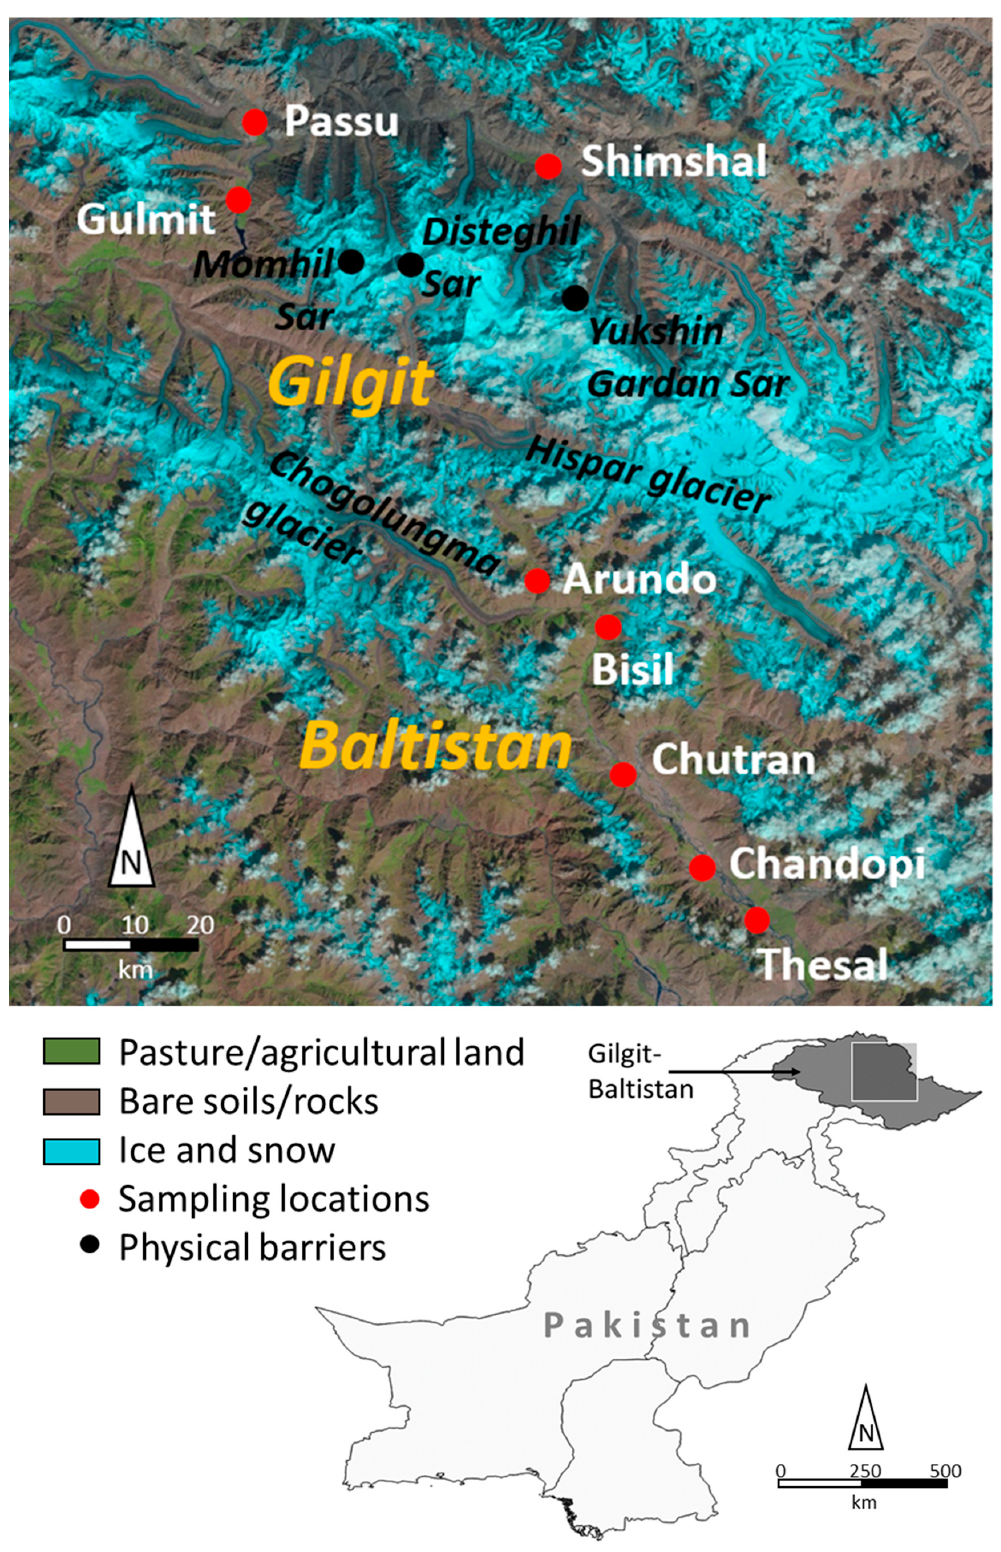
Figure 1. Map of the studied populations in the Gilgit and Baltistan regions, northern Pakistan used for sea buckthorn collection in 2016 (sources: Landsat picture (2015), modified, Image courtesy of the U.S. Geological Survey ( above ); Pakistan and administrative areas, modified, diva-gis.org, accessed 30 July 2018 ( below )).